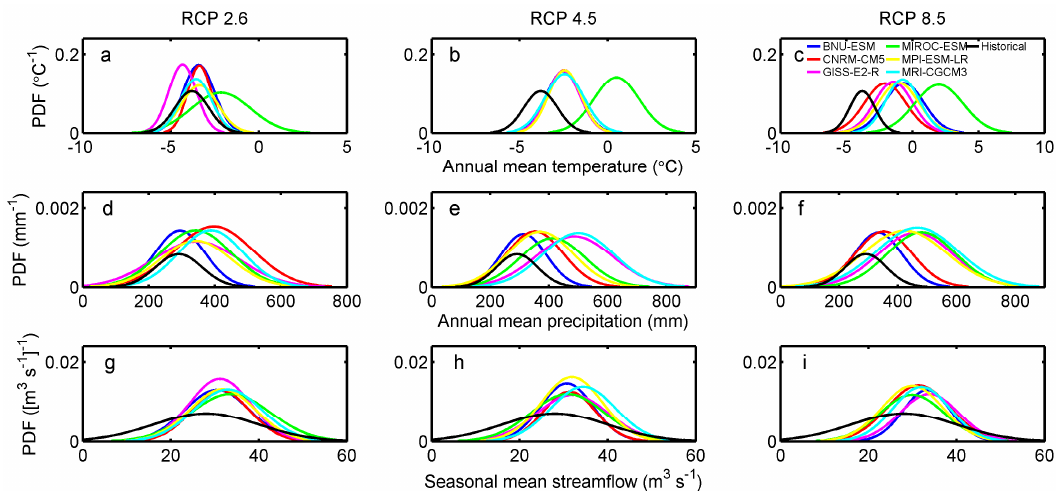
Figure 9. Box plots of change ratios in seasonal streamflow (%) in the future periods (( a ) 2020s, ( b ) 2050s and ( c ) 2080s) under RCPs (RCP2.6, RCP4.5 and RCP8.5).